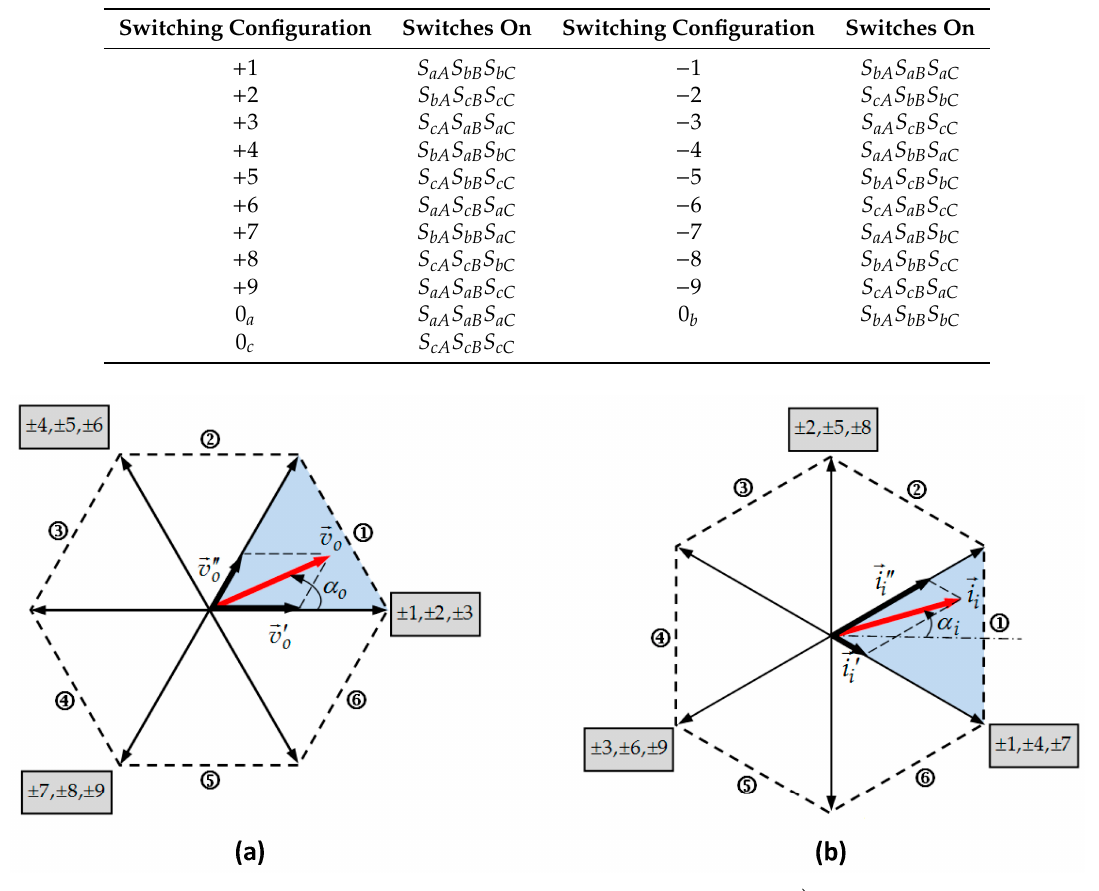
 → . Figure 3. Vector hexagons formed by ( a ) i i i i